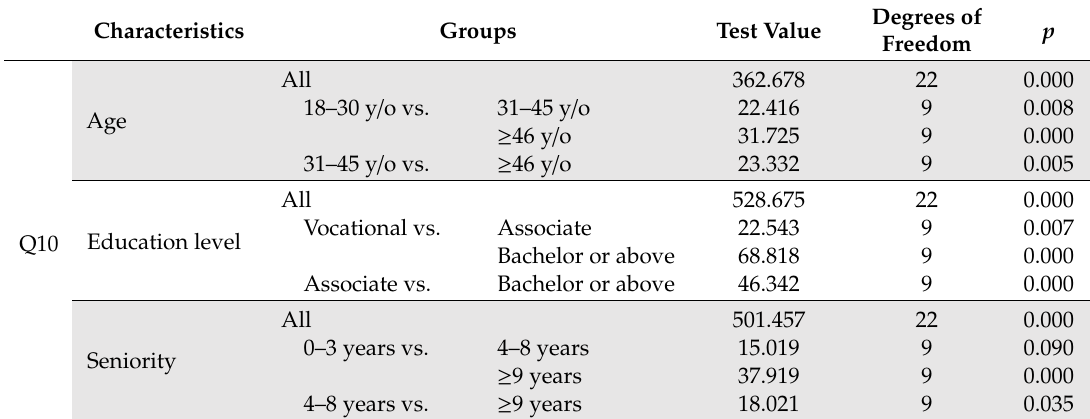
Table 6. Di ff erences between age, education level, and seniority groups for Q10 (facilitators).